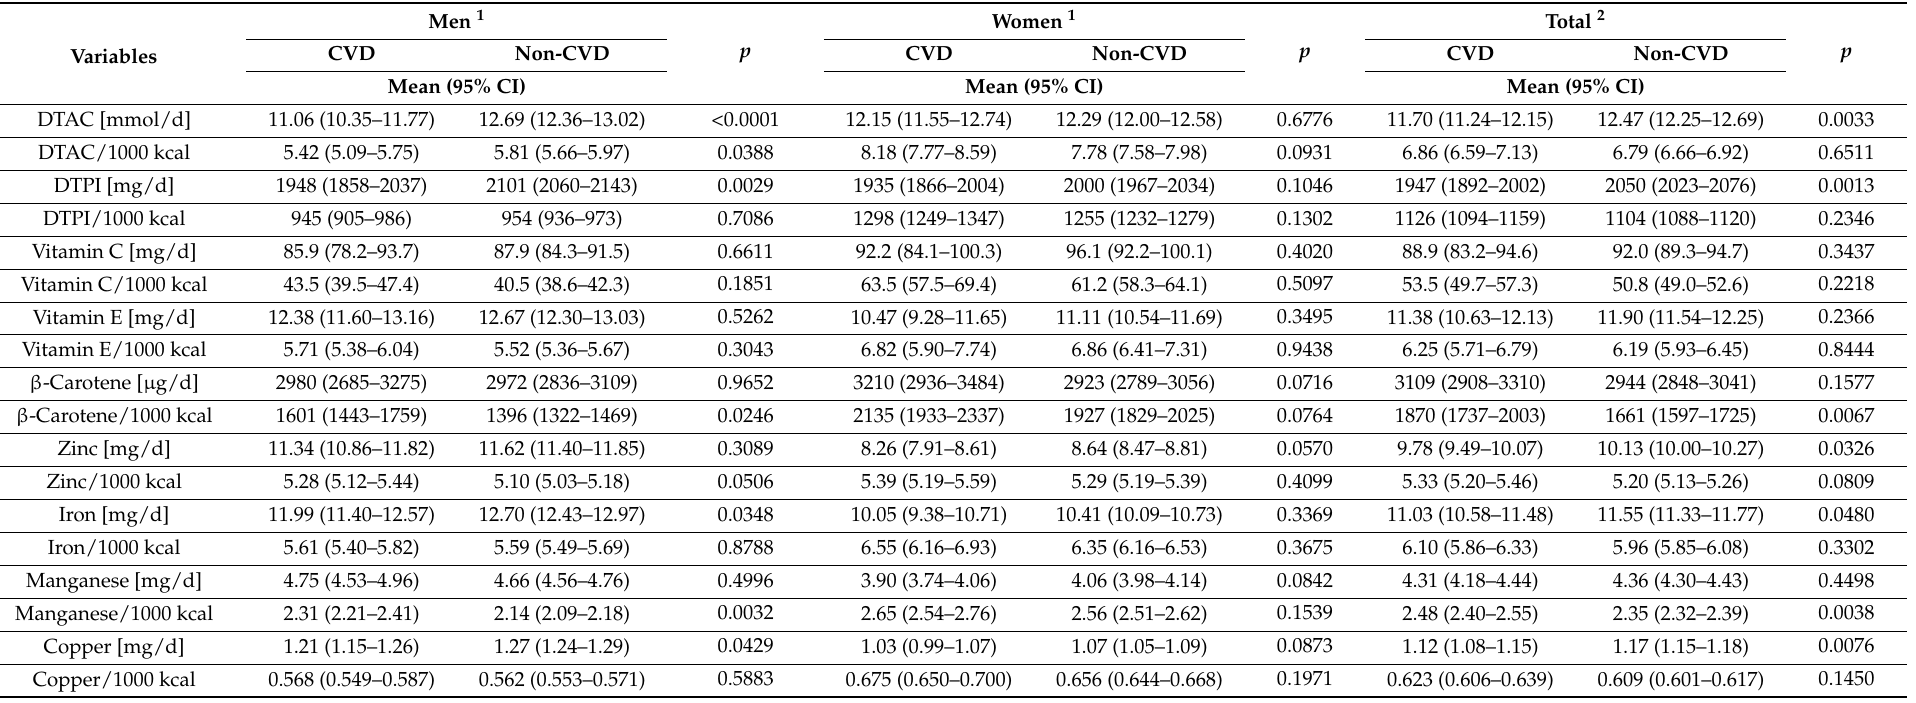
Table 2. Comparison of antioxidant intake from food and supplements between CVD and non-CVD participants according to sex and